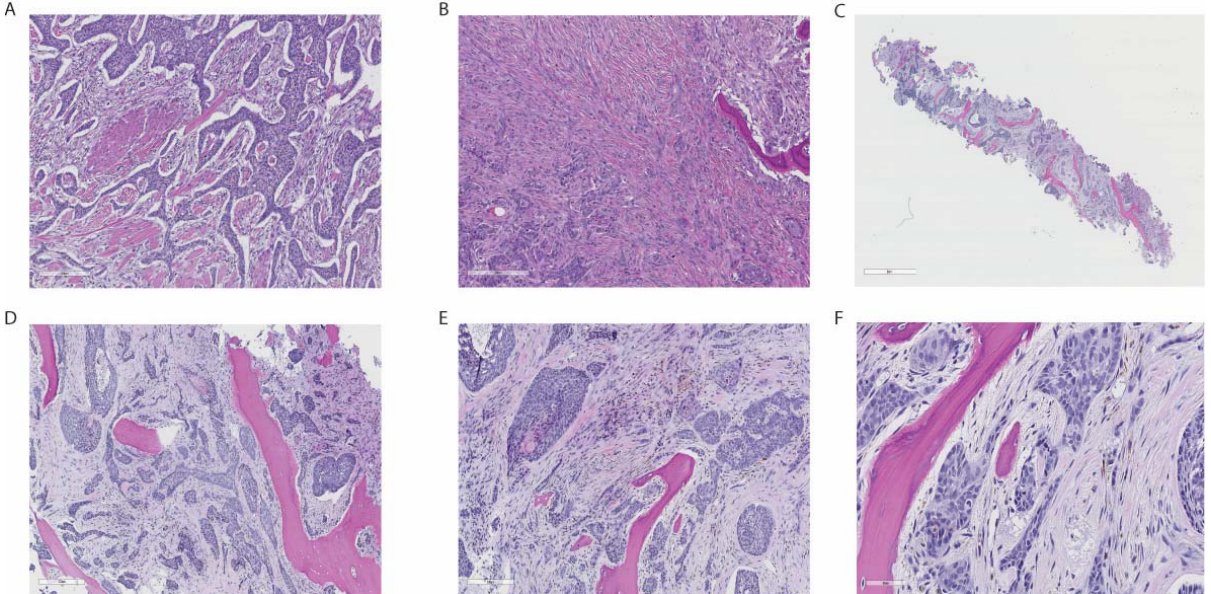
Table 1. Blood tests.